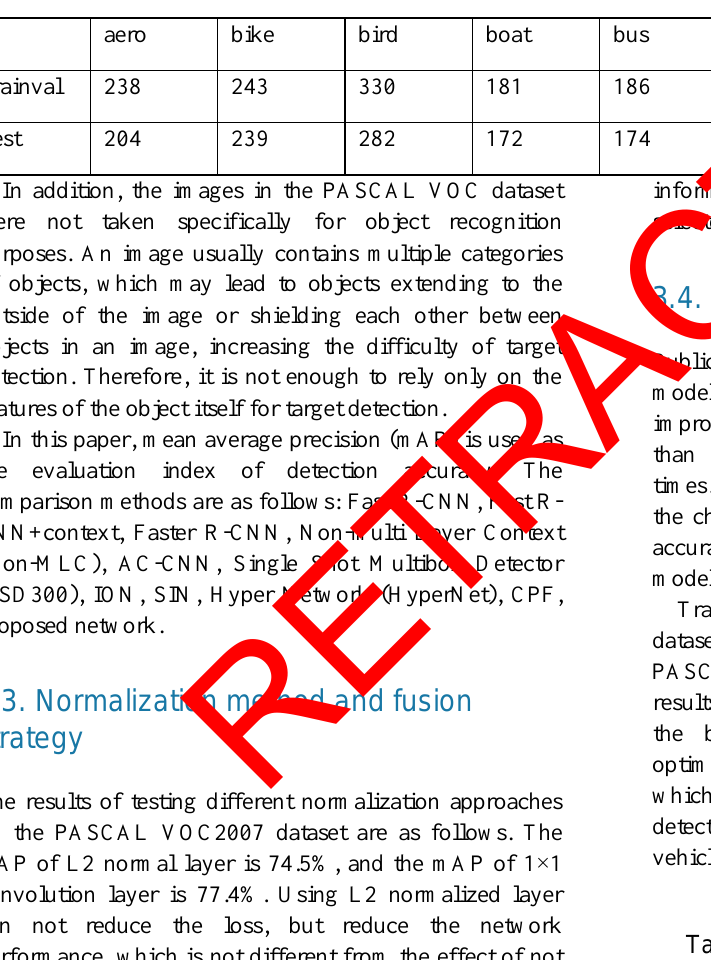
Table 2. Test results of 5 methods on